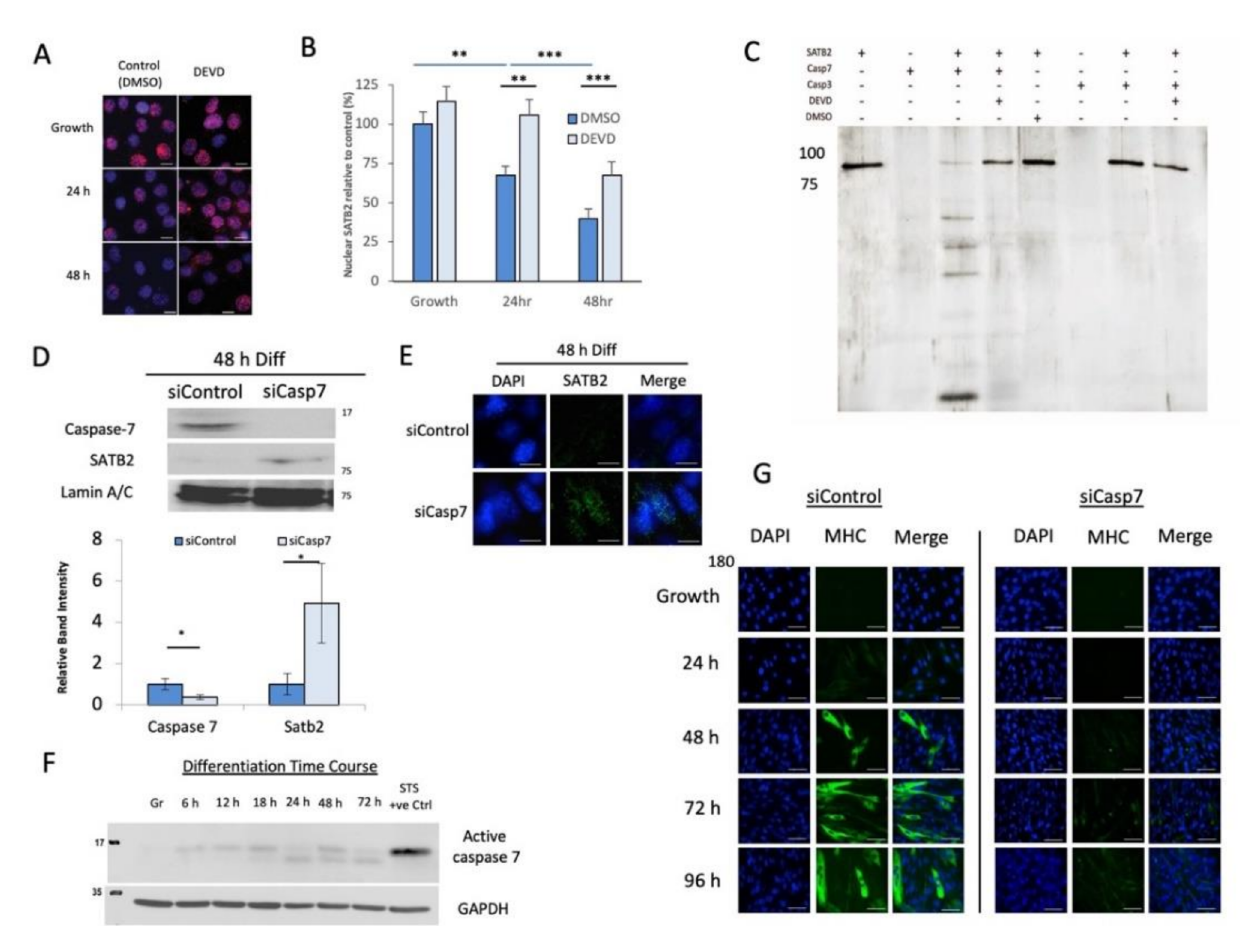
Figure 2. Caspase 7 cleaves SATB2 during early skeletal muscle differentiation and is necessary for myogenesis. ( A ) Immunofluorescent staining showing the maintenance of SATB2 expression following caspase inhibition by z-DEVD.fmk (DEVD) in differentiating C2C12 cells. Images are representative of n = 3 determinations on independent samples. DAPI (blue); SATB2 (red); scale: 10 µ m. ( B ) Quantification of SATB2 nuclear expression following DEVD-mediated suppression of caspase activity. Data are the means ± SEM from n = 3 independent samples; 75–100 cells per condition/time point were analyzed. ** indicates p < 0.01 and *** indicates p < 0.001, as determined by the Student’s t -test. ( C ) Silver stained gel of an in vitro caspase cleavage assay showing SATB2 cleav- age by caspase 7. Reactions include combinations of recombinant SATB2 protein, active caspase 3/7 recombinant proteins, caspase chemical inhibitor (DEVD), or the control chemical DMSO ( n = 3). ( D ) Caspase 7 and SATB2 expression following siCasp7 and siControl treatments of C2C12 cells. Both the histogram and the representative western blots ( n = 3) were the expression levels of those two proteins 48 h post-induction of differentiation. * indicates a significant difference in caspase 7 or SATB2 expression, as determined by the Student’s t -test ( p < 0.05). ( E ) Immunofluorescent images showing the sustained expression of SATB2 after the depletion of caspase 7 in C2C12 cells differenti- ated for 48 h. Images are representative of n = 3 independent determinations. Scale bars = 10 µ m. ( F ) Representative western blot depicting the cleaved active fragment of caspase 7 found in the nuclear fraction of C2C12 cells during their proliferative phase (Gr) and at various stages of differentiation (6–72 h post-induction; n = 3). Staurosporine (STS) was administered to proliferating C2C12 cells to induce apoptosis as a positive control. ( G ) Immunofluorescent images showing the reduction in myosin heavy chain (MHC) expression in differentiating C2C12 myoblasts. Panel is representative of n = 3 determinations on independent samples. DAPI (blue), MHC (green). Scale bars = 50 µ